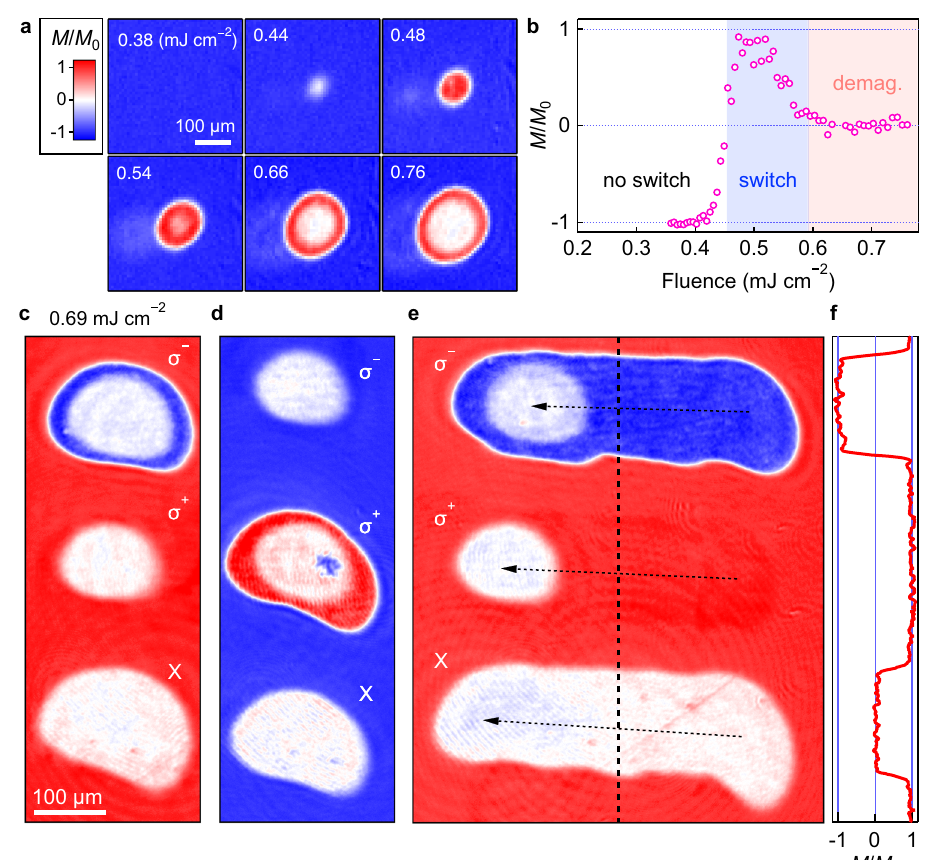
Fig. 3 Light control of magnetization in Co 3 Sn 2 S 2 . a Magnetization images of initially saturated ( M = M 0 = − 1) Co 3 Sn 2 S 2 fi lm at 100 K after exposure to 10 4 pulses of σ þ polarized mid-infrared (MIR) light under the indicated pump fl uences. The color scale indicates the magnetization at each position M divided by the saturated value M 0 , therefore M = M 0 = − 1( + 1) corresponds to the spin down (up) state. b Magnetization at the beam center as a function of pump fl uence. c Magnetization image after the spot excitation by σ (cid:1) , σ þ , and X polarized light at 100 K for the initially magnetization of M / M ( c ), but the initial magnetization is opposite ( M / M 0 = − 1). e Line scans for σ (cid:1) , σ þ , and X polarized light. The laser beam was swept from right to left (indicated by black dotted arrows), and the magnetization pattern was subsequently imaged. For ( c ) – ( e ), the pump fl uence was set to 0.69 mJ cm − 2 , and the color scale for ( a ) is also applied. f Line pro fi le along the vertical dashed line in ( e